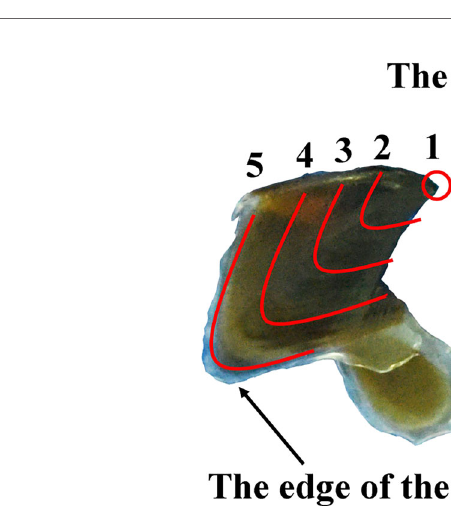
FIGURE 2 | Lateral view of the lateral wall for lower beak (1 – 5 represent the tip of the rostrum, 5.0 mm, 10.0 mm, and 15.0 mm along the lateral wall, and the edge of the lateral wall, respectively).